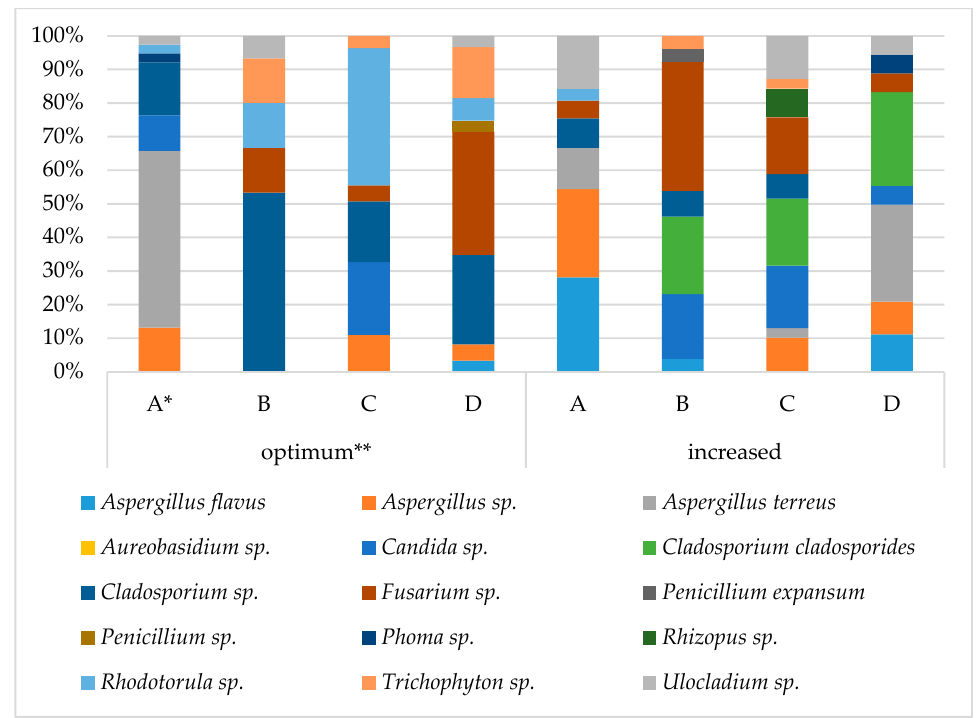
Figure 6. Identified mold fungi in grain of spelt wheat cv. “Schwabenspelz” (%) (mean for 2014–2015). Note: * crop protection methods, ** seeding density.